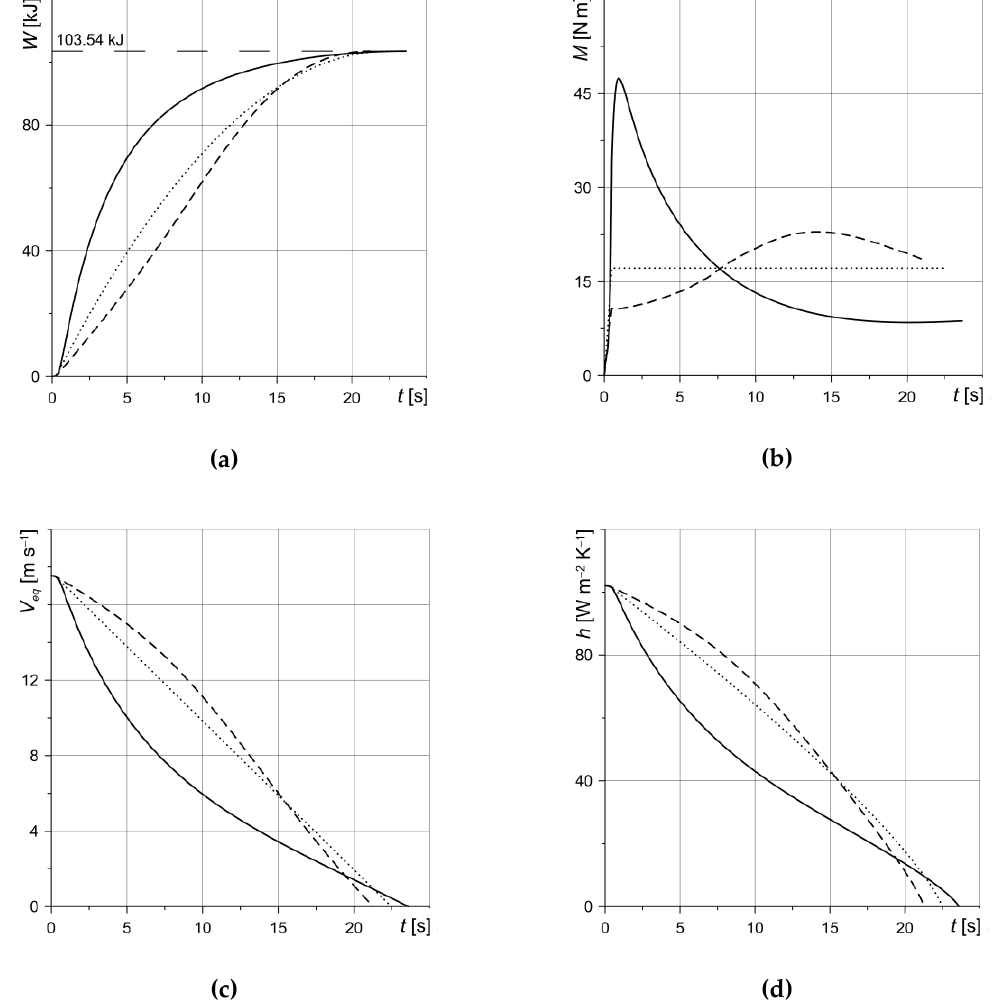
Figure 5. Change in: ( a ) work done W ; ( b ) braking torque M ; ( c ) linear velocity V eq ; ( d ) heat transfer coefficient h ( V eq ) during braking. Solid line—variant 1, dashed line—variant 2, dotted line—variant 3.